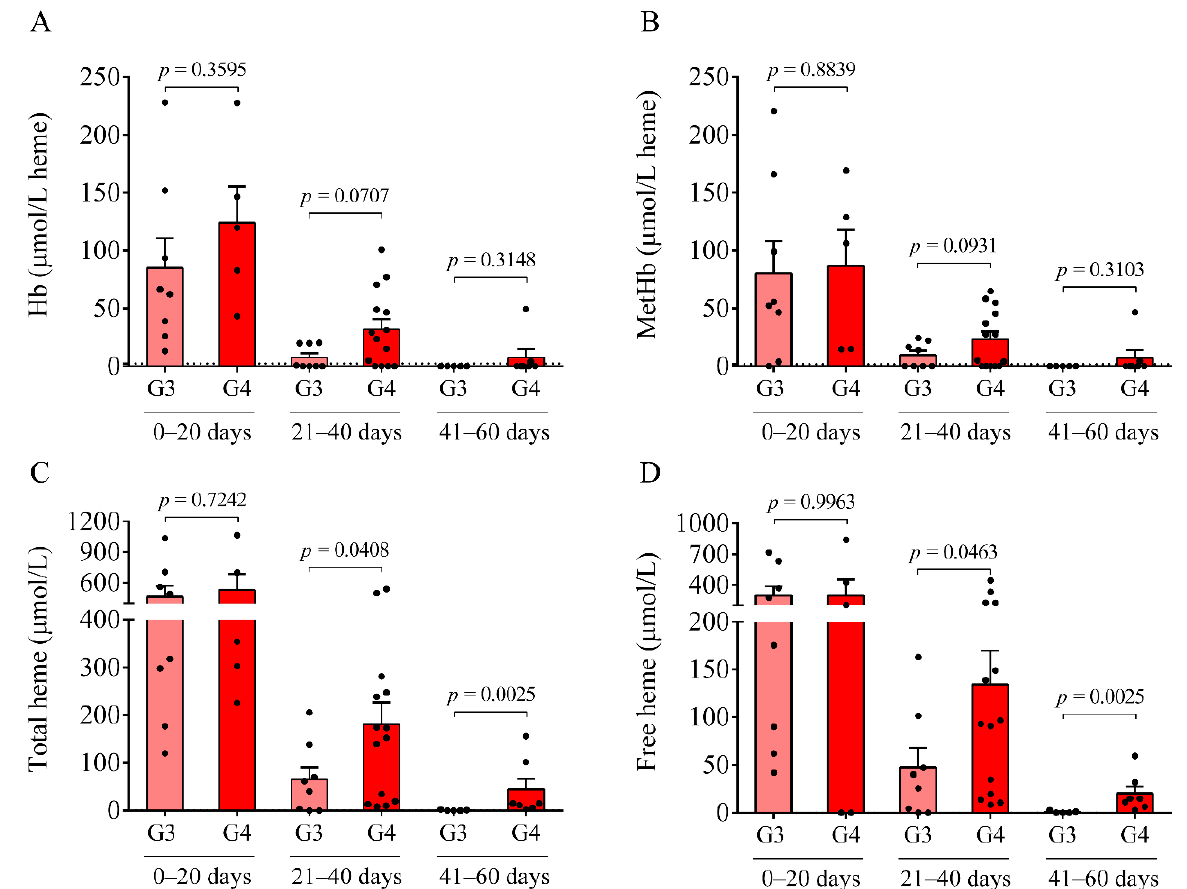
Figure 2. Analysis of the levels of Hb, metHb, and total and free heme in IVH-III (G3) and IVH-IV (G4) CSF samples at different time intervals after the disease onset. A time-dependent alteration of Hb ( A ), metHb ( B ), and total and free heme ( C , D ) was uncovered in post-IVH CSF samples, which was more pronounced in Grade-IV IVH patients (G4, red) compared to the Grade-III group (G3, light red). Dots represent single values. Mean ± SEM are depicted. Dotted lines depict the mean value of the particular parameter measured in preterm non-IVH control samples [23]. Mean total heme was as low as 0.8 µ mol/L and free heme was practically undetectable in the control samples, and this is why the dotted lines cannot be recognized in parts C and D. To compare the data of the two groups, the Mann–Whitney U test or unpaired t -test was applied. Abbreviations: CSF, cerebrospinal fluid; G3, Grade-III IVH; G4, Grade-IV IVH; Hb, hemoglobin; IVH, intraventricular hemorrhage; and metHb, methemoglobin.